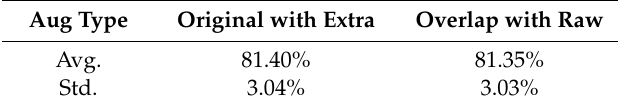
Table 10. Test accuracy of augments applied in full pre-trained network.